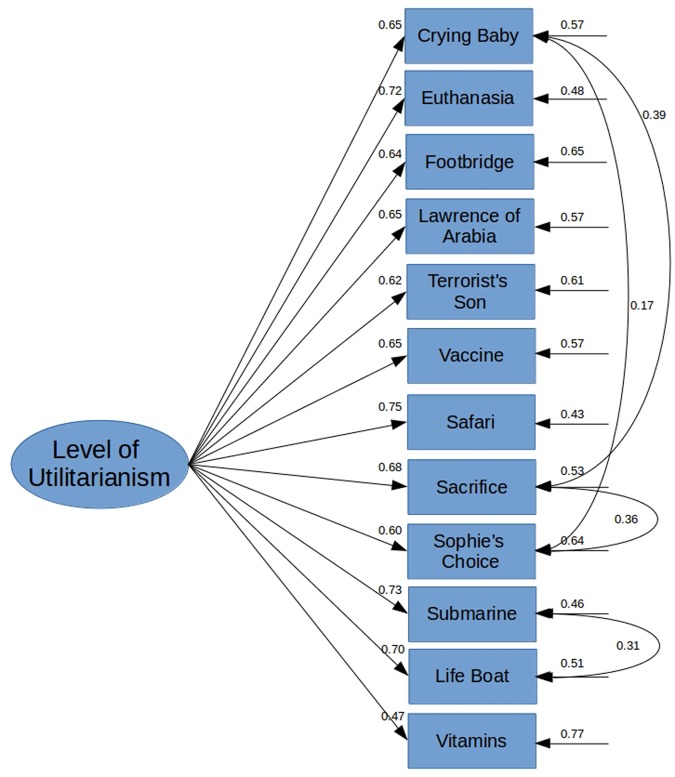
Results for Study 2.